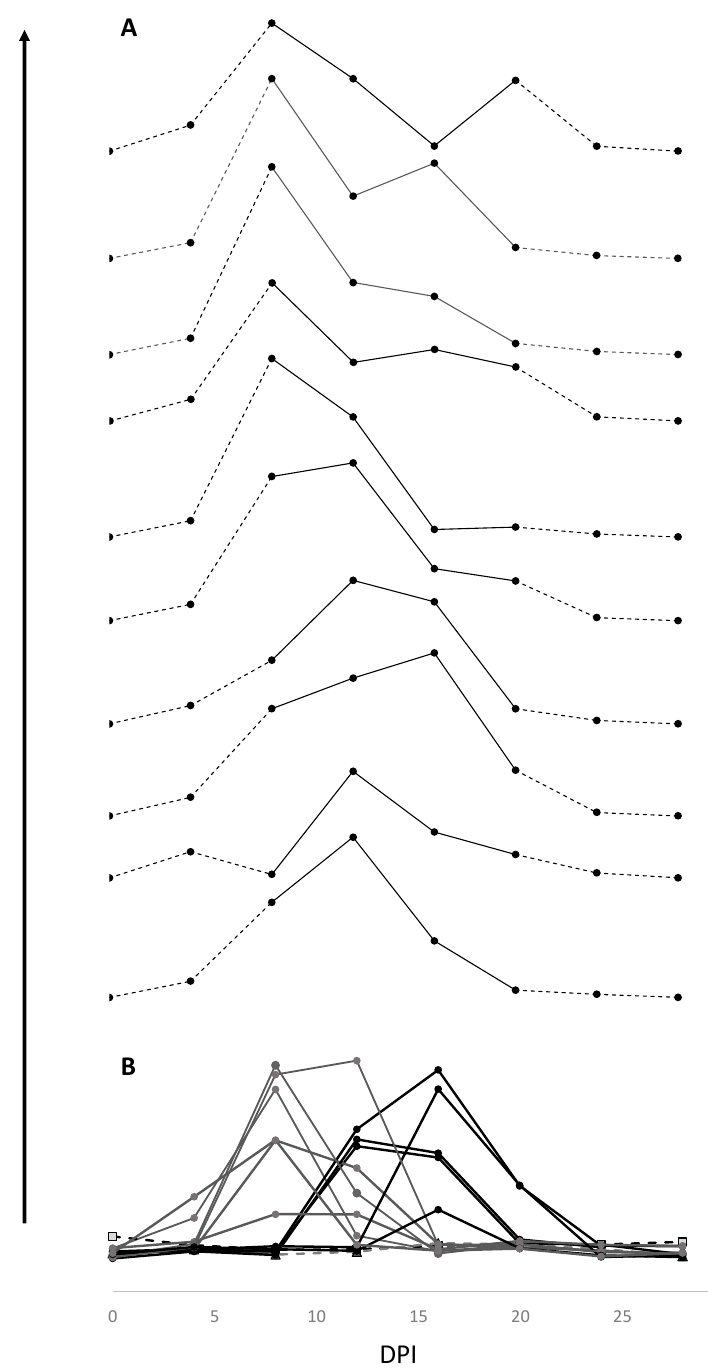
Figure 5. ( A ) Ten theoretical viremia kinetics constructed by randomly resampling individual non- lethal data to model a lethally sampled dataset (n = average of viremia levels from 3 different fish for each dpi 7–20). ( B ) Viremia kinetics from actual non-lethal sequentially sampled fish (n =